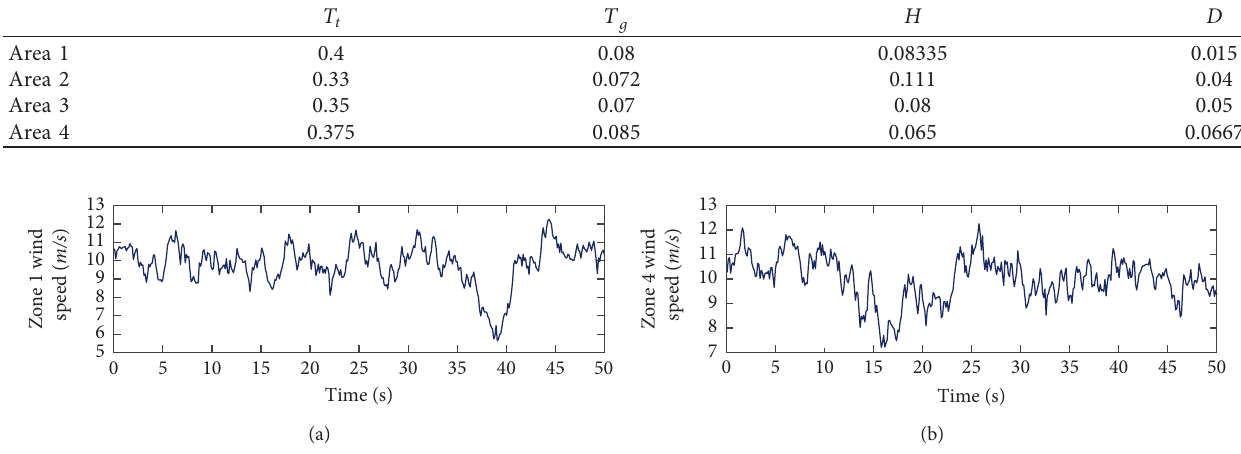
Table 4: Simulation rated parameters of four-zone microgrid with non-reheat prime mover.